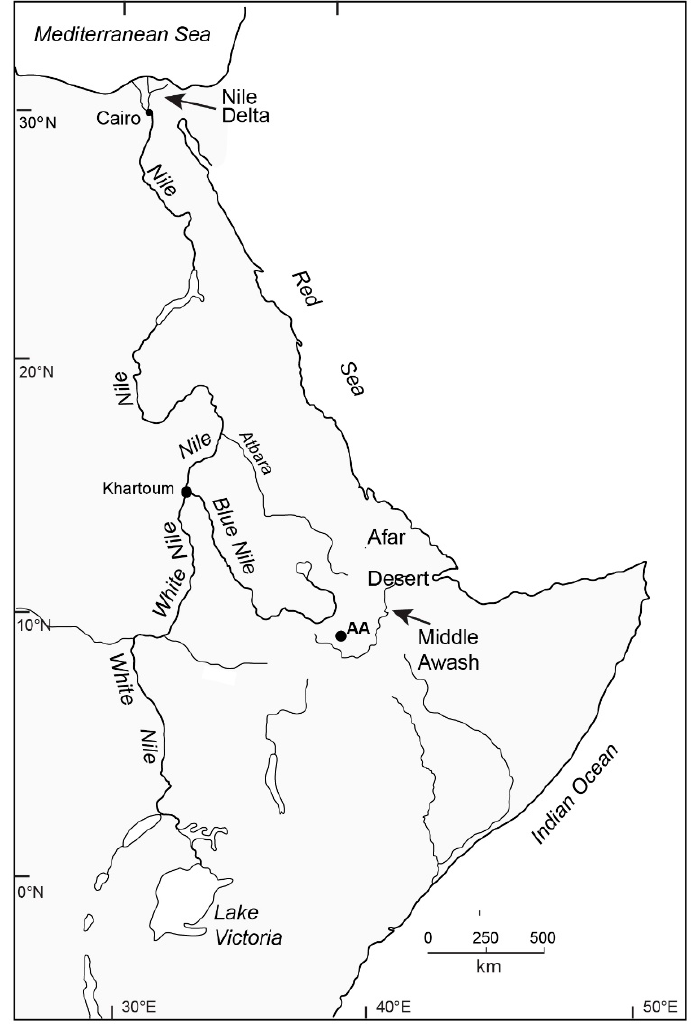
Figure 5. Nile basin location map. AA is Addis Ababa, capital of Ethiopia.